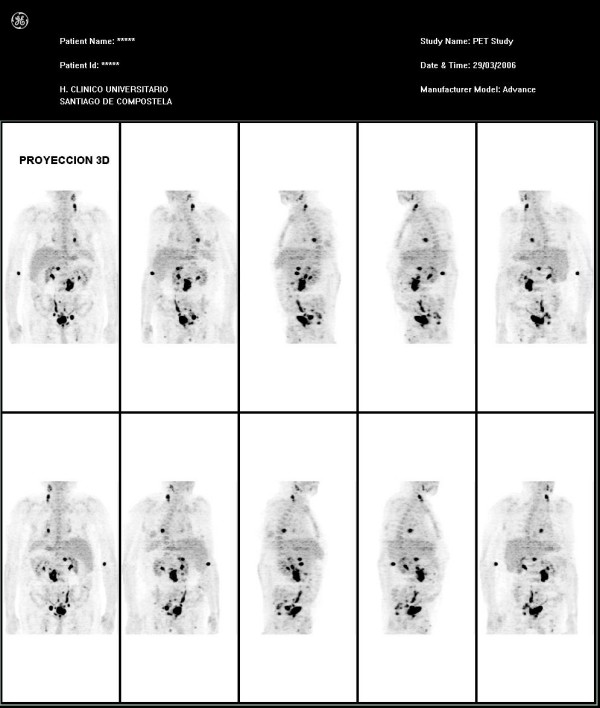
This image shows the PET findings in a three-dimensional projection view.